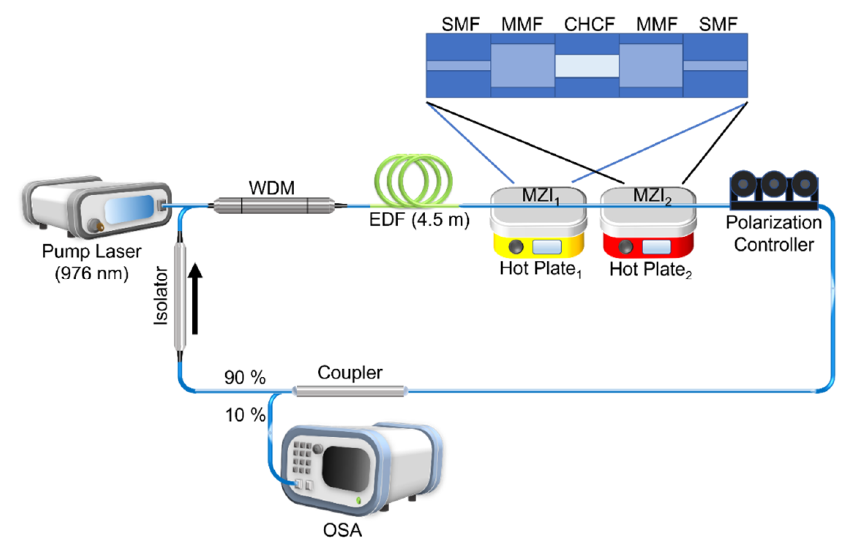
Figure 1. Schematic of the fiber ring laser using two cascaded MZIs.